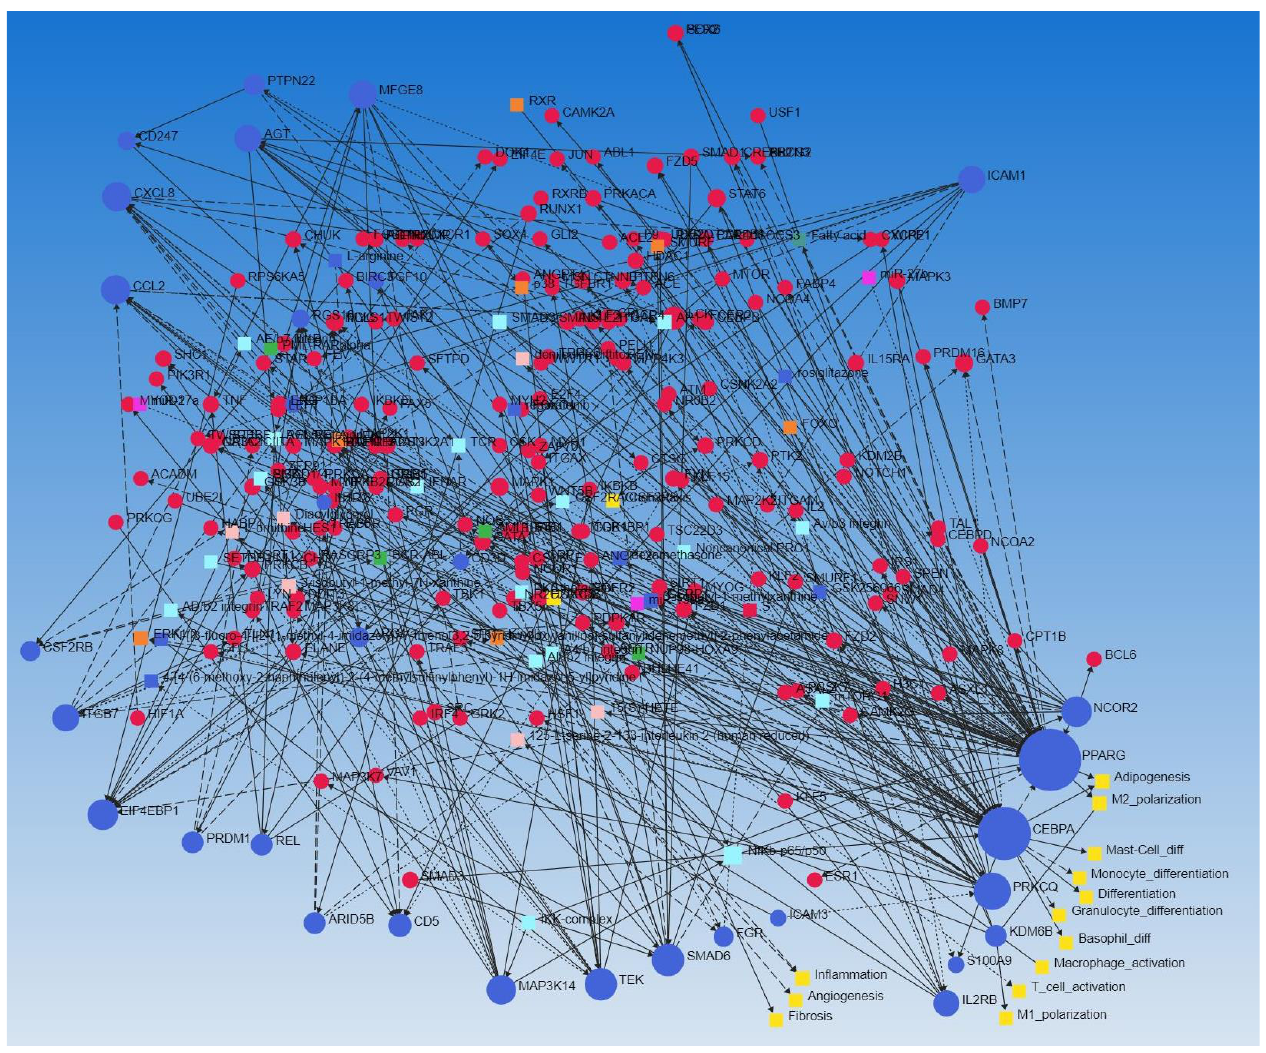
Figure 3. Signor network analysis of the DEGs. The network analysis showed the correlation of DEGs with each other. Blue circles show the DEGs listed in Tables 2 – 5 and involved in inflammation, immune response, and remodeling (CXCL8, CCL2, ICAM1, ICAM3, ITGB7, PPARG, REL, IL2, S100A9, etc.), yellow circles show cellular mechanisms involved in chronic inflammation and plaque formation including macrophage polarization, fibrosis, inflammation, angiogenesis, and lymphocytes activation.